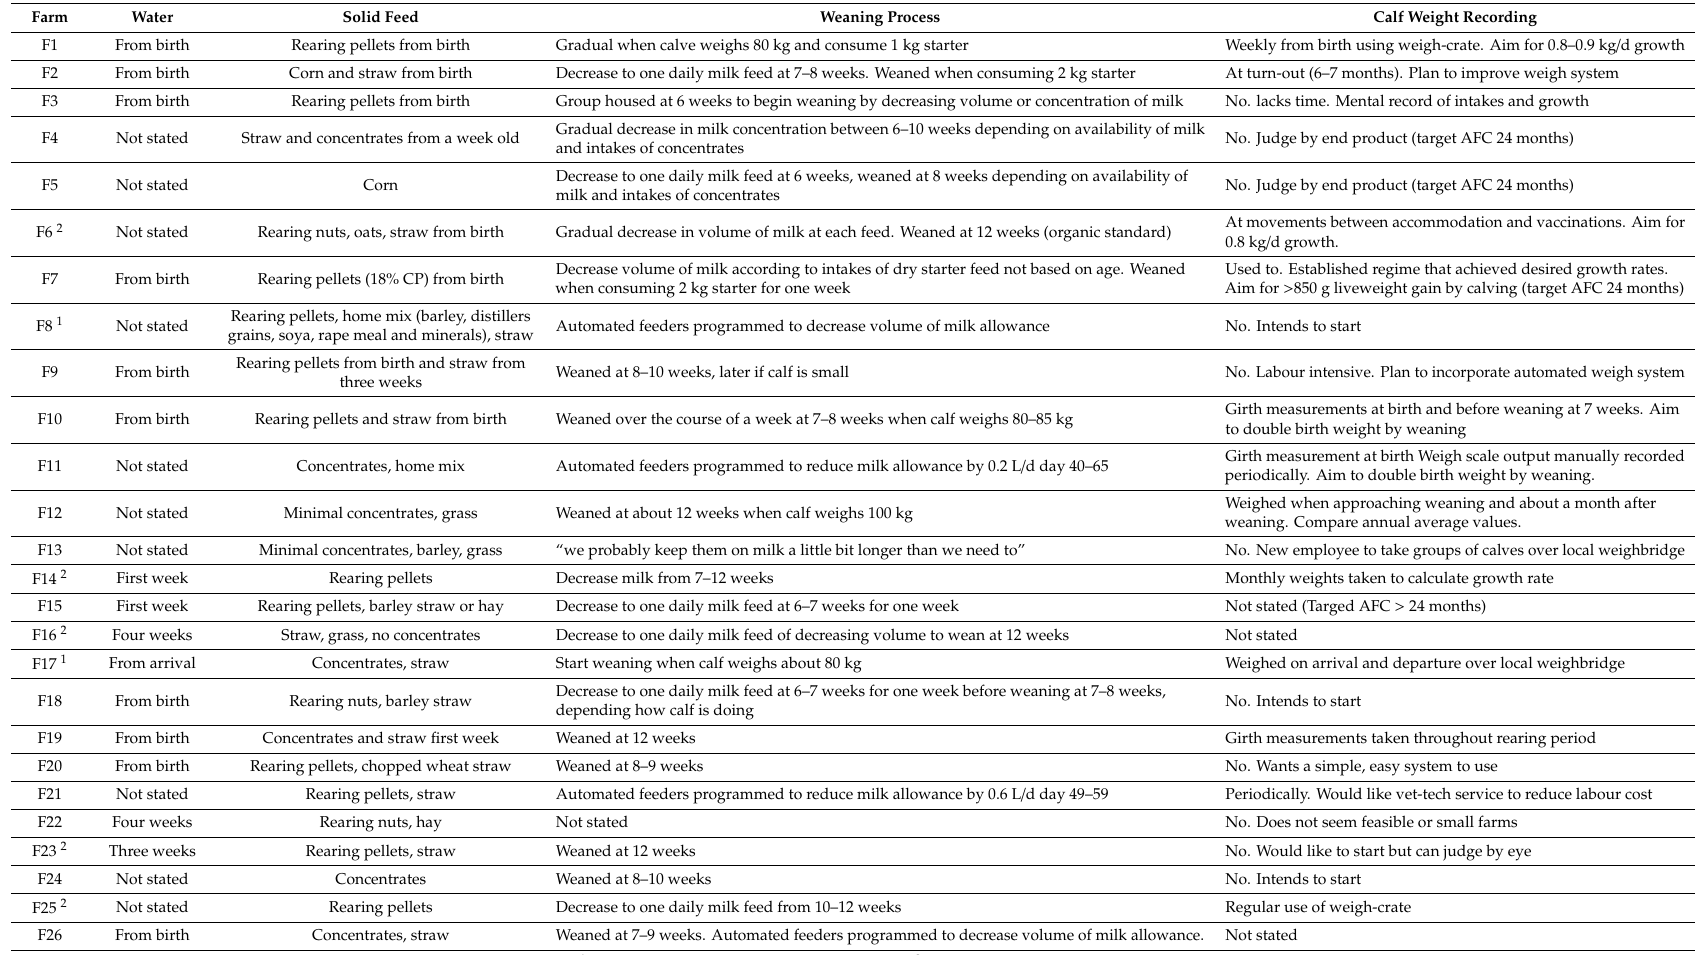
Abbreviations: age at first calving (AFC), crude protein (CP). 1 Rears dairy bull or beef cross calves. 2 Organic. Since no quantitative survey of farm practices was conducted, some details were not included in the interviews—this does not necessarily indicate that calves were not provided with components e.g., straw, water. Straw is stated where it is provided as a feed substrate rather than as